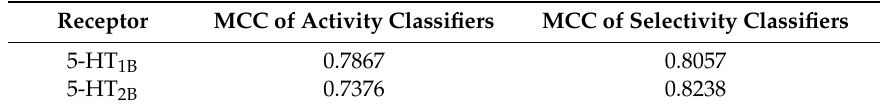
Table 4. Performance data of the activity and selectivity filters obtained on ChEMBL training set.